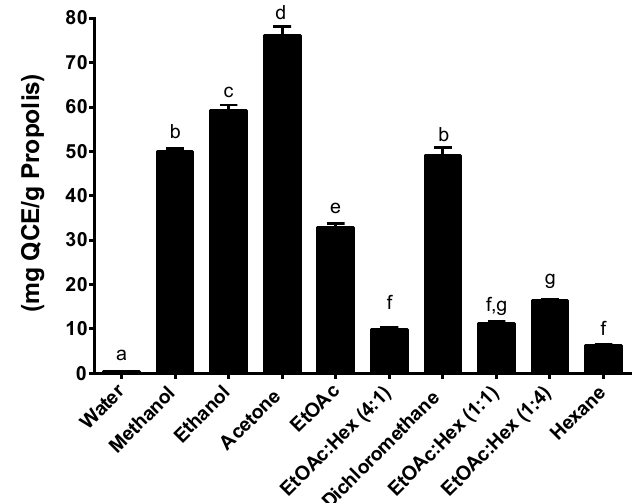
Figure 4. Total flavonoid content following SE. Values are the means ± SEM of at least three independent experiments, each performed in duplicate; values with different superscripts are significantly different ( p < 0.05) as determined by one-way ANOVA test with subsequent Tukey’s adjustment; QCE: quercetin equivalent.